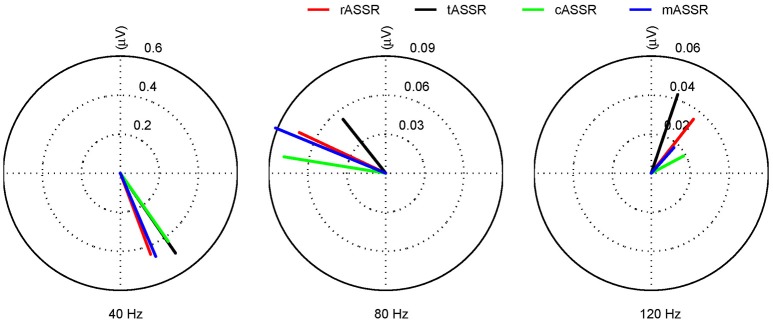
The first three harmonics of tASSR, cASSR, mASSR, and rASSR. All harmonics (40, 80, and 120 Hz) are represented as vectors with RMS amplitude (μV). rASSR: red, tASSR: black, cASSR: green, and mASSR: blue.